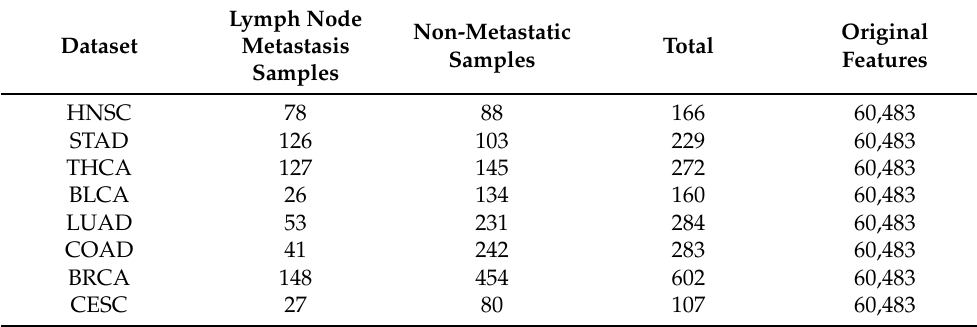
Table 1. The statistics of eight cancer-related lncRNA